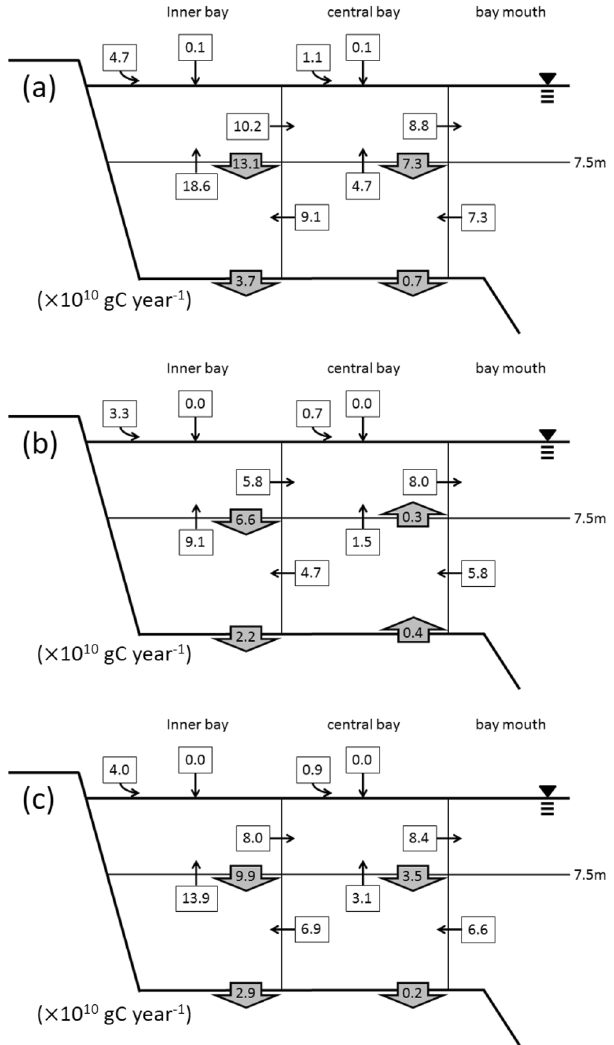
Figure 5. Average total organic carbon (TOC) flow in Tokyo Bay during ( a ) May and October (stratified season), ( b ) November and April (vertically mixed season), and ( c ) entire year. Numbers with black and gray squares denote each carbon flux (× 10 10 gC year -1 ). Curved and straight arrows from outside box (Boxes 1 and 3) indicate TOC input from land and TOC precipitation, respectively. Numbers with gray square indicate TOC sedimentation (downward arrow) or resuspension (upward